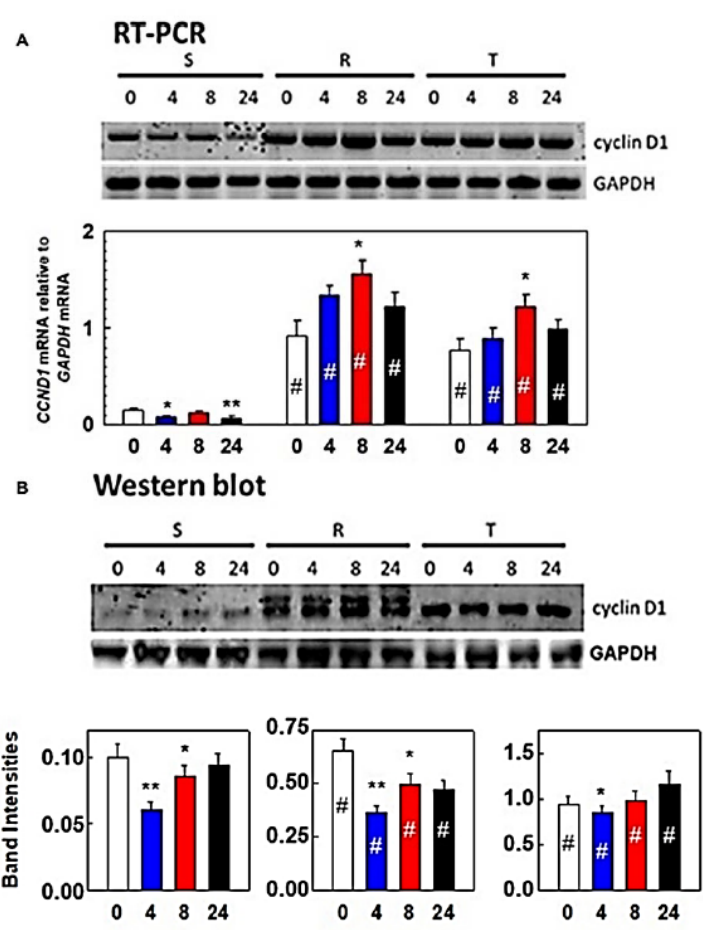
Figure 4. Expression of cyclin D1 in the presence or absence of tunicamycin: Respective mRNAs were detected by RT-PCR ( A ) and proteins were detected by Western blotting ( B ). S, R, and T cells were incubated in the presence or absence of tunicamycin for 4, 8, and 24 h. Signals for GAPDH mRNA and protein were used as internal controls. Data are representative of three independent